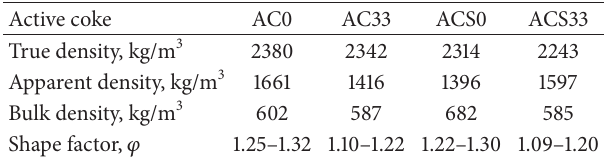
Table 1: Densities and shape factors ( 𝜑 = 1/ 𝜓 , where 𝜓 = Wadell sphericity factor).